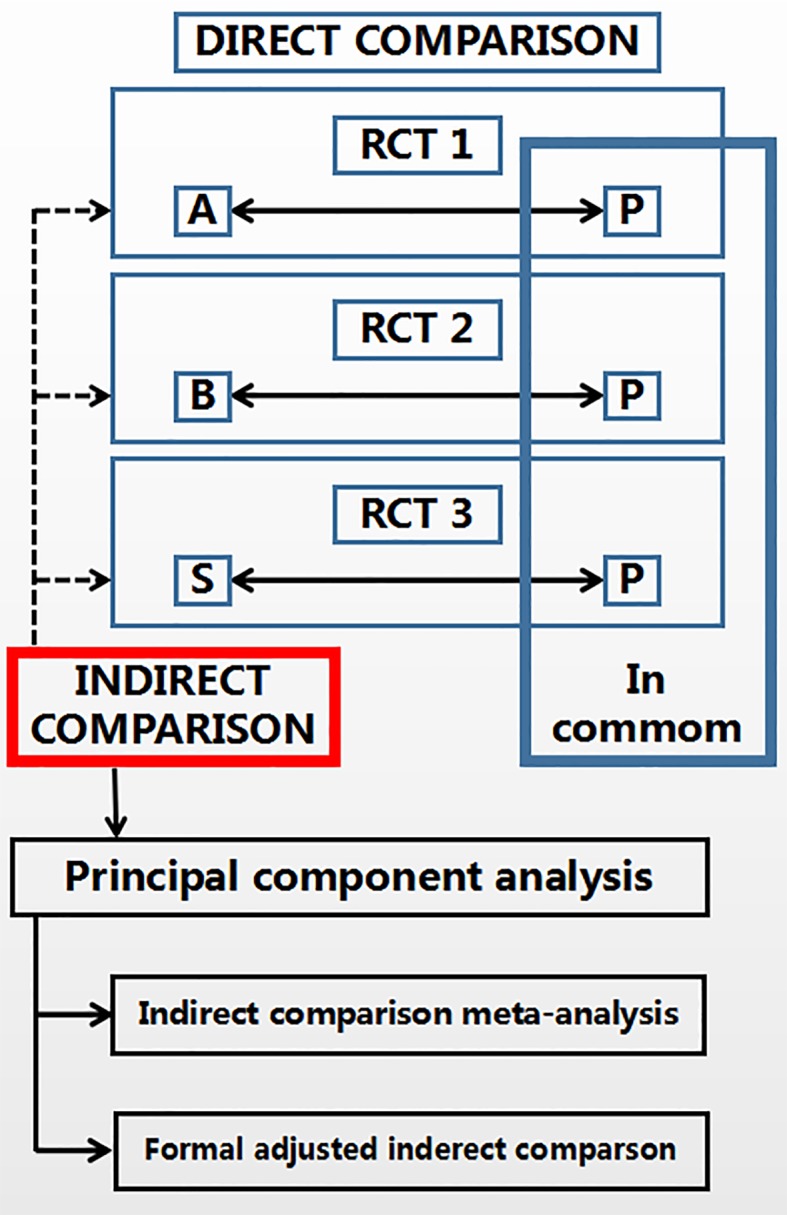
Study flow diagram.